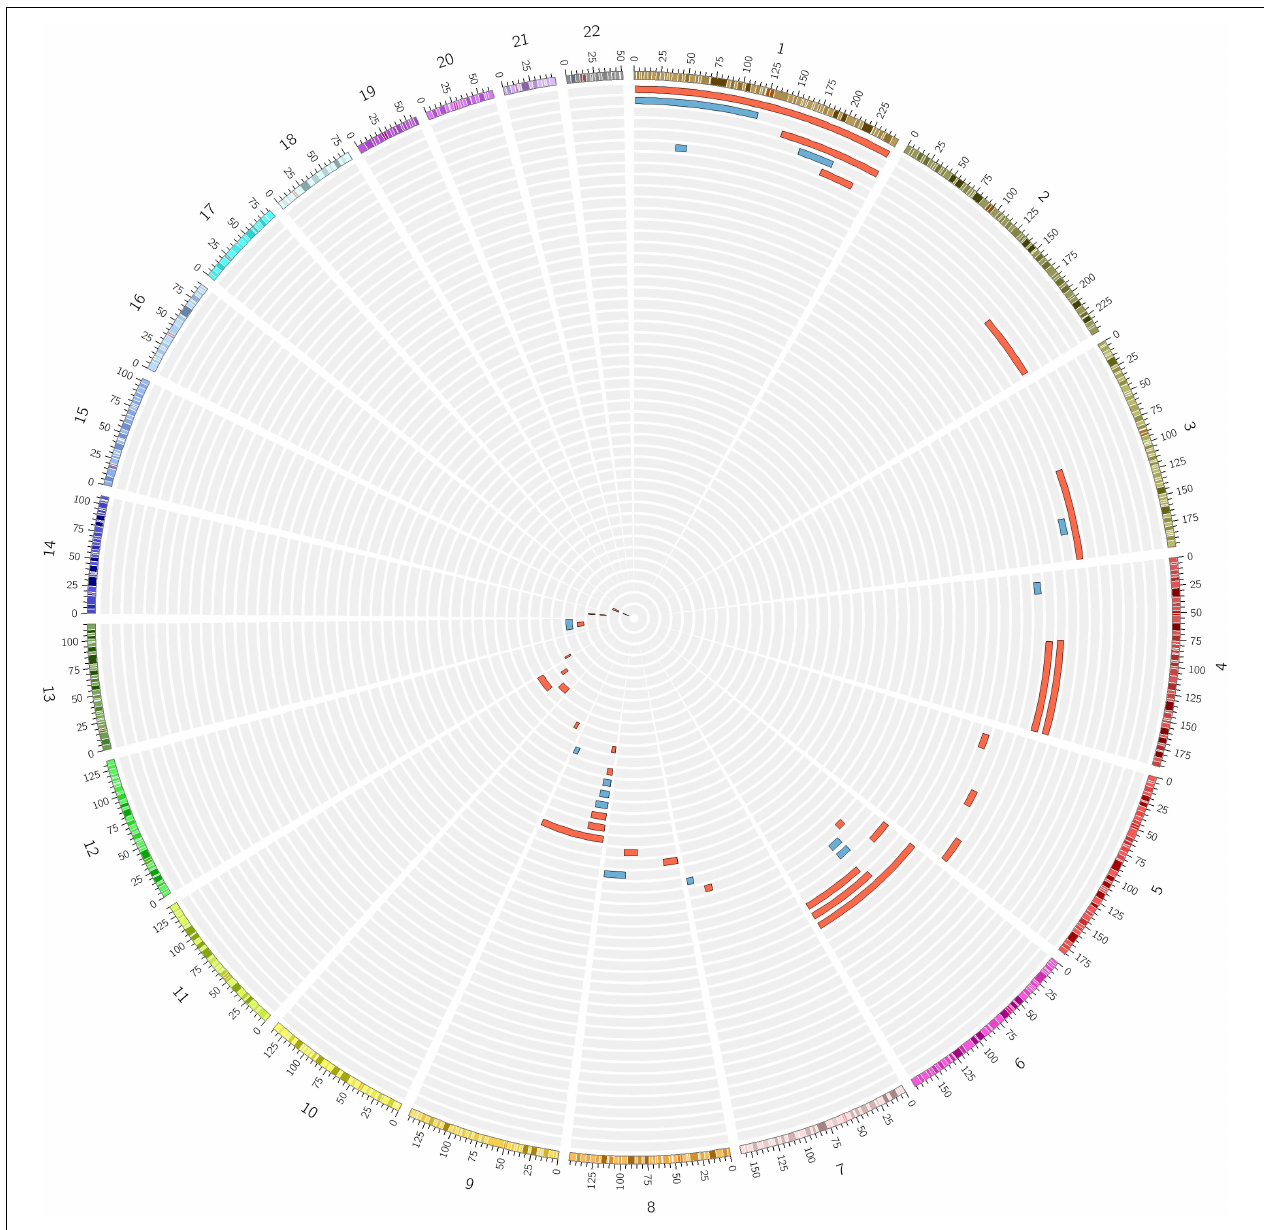
FIGURE 4 | Numerous cases of putative isodisomy misidentified as consanguineous subjects. Fifty-six subjects identified as consanguineous by FSuite v1.0.3 (Gazal et al., 2014) showed a single homozygous region over 10 Mb on just one chromosome, the homozygosity cut-off previously reported to define the presence of putative uniparental isodisomy (UPD). Two female subjects showing a putative UPD on X-chromosome are not shown. Red = LOAD; Blue =